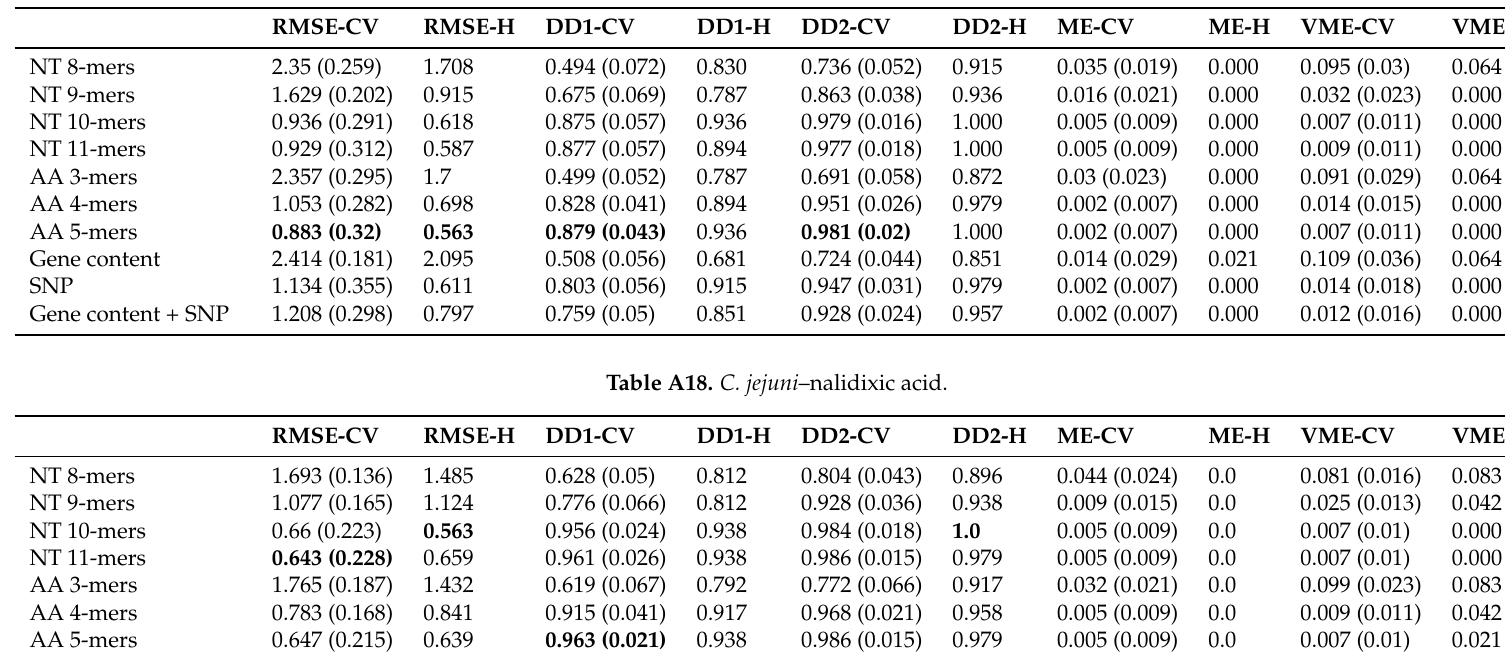
Table A17. C. jejuni –ciprofloxacin.